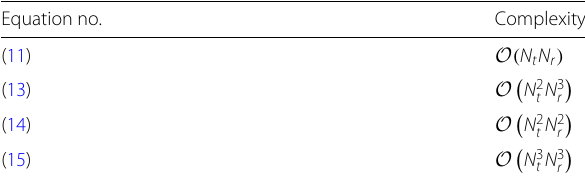
Table 2 Complexity of each step of EKF algorithm Equation no.